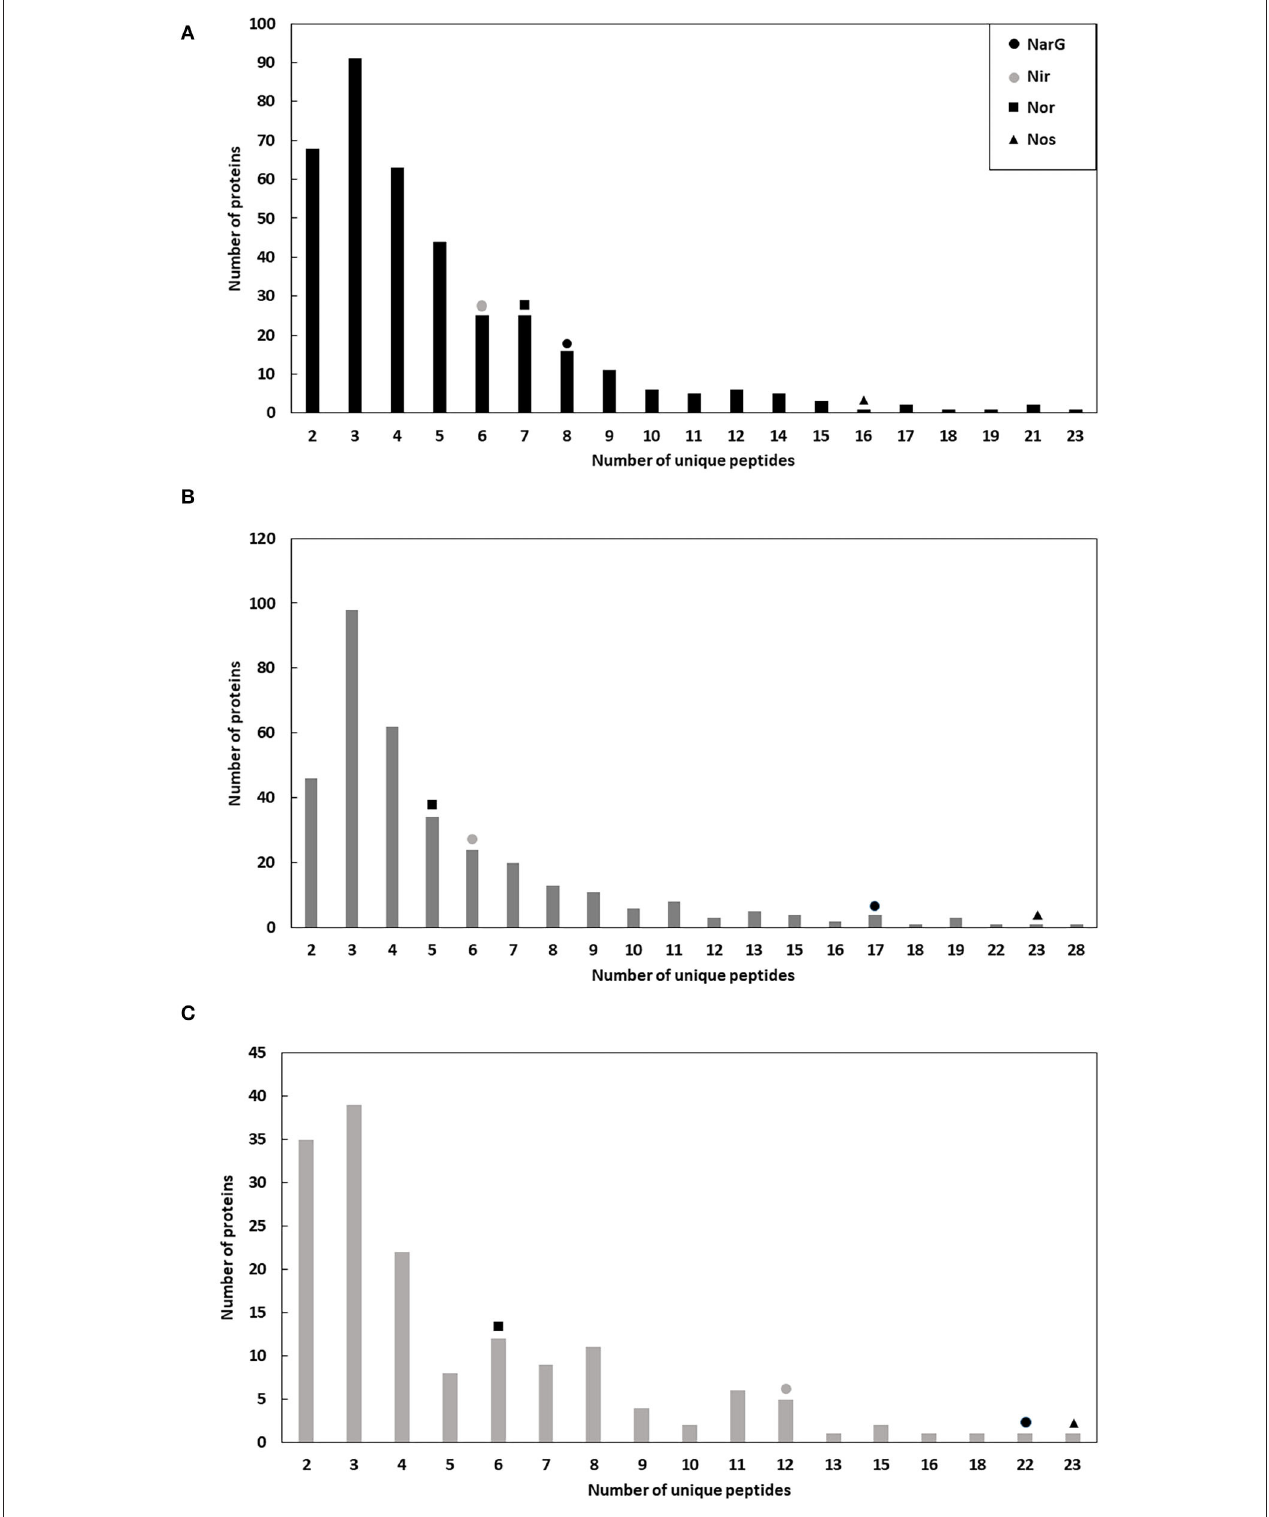
FIGURE 2 | Number of proteins with different and unique peptides in the micelles during the enrichment process: crude extract (A) , DEAE-Sepharose (B), and Q-Sepharose (C) . Positive identifications are considered only when two or more peptides are matched, and their summed score is > 30.